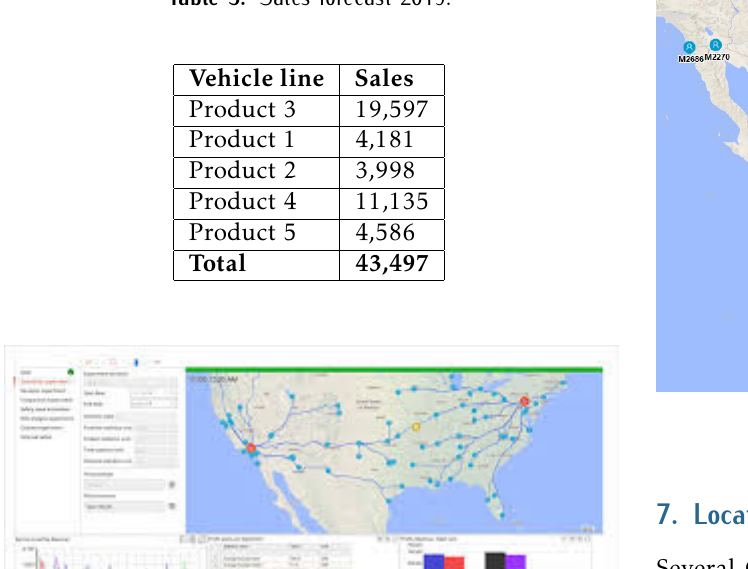
Table 5. Sales forecast 2019.